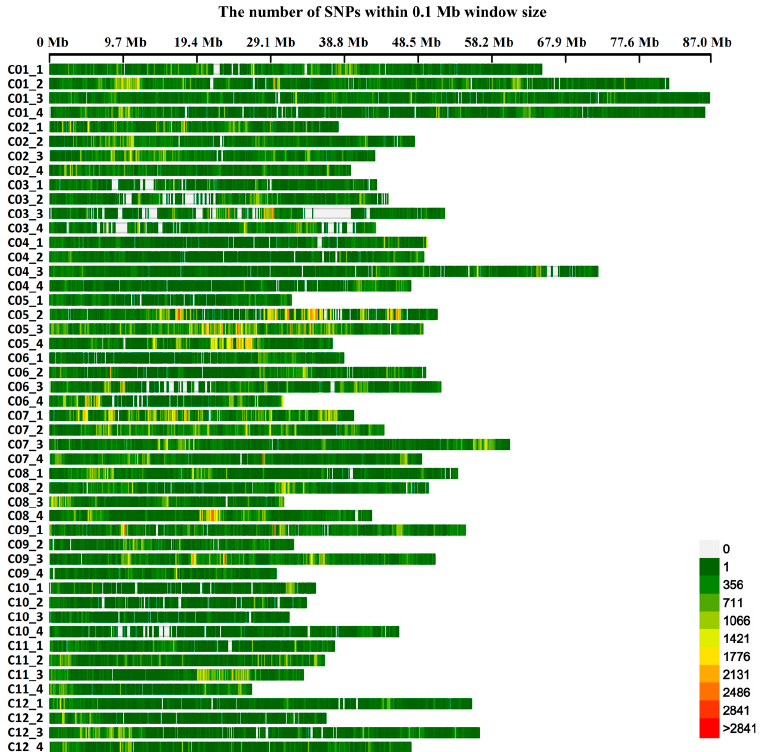
Figure 2. SNP distributions on the 48 chromosomes of potato . The horizontal axis displays the chromosome length; the 0–2841 legend insert indicates the SNP density.